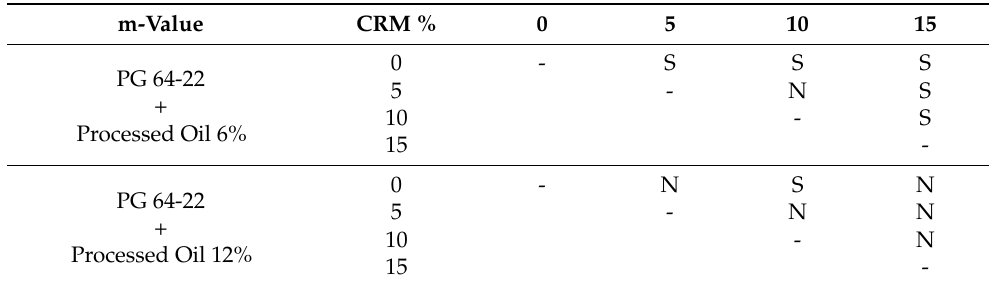
Table 11. Statistical analysis results of m-value for RTFO + PAV aged PG 64-22 with processed oil as a function of CRM content − 12 ◦ C ( α = 0.05).